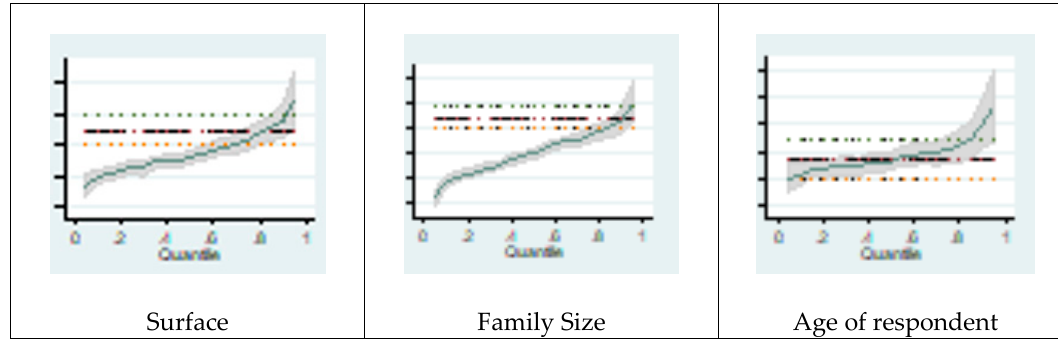
Figure 3. Electricity poverty. Some quantile coefficients.